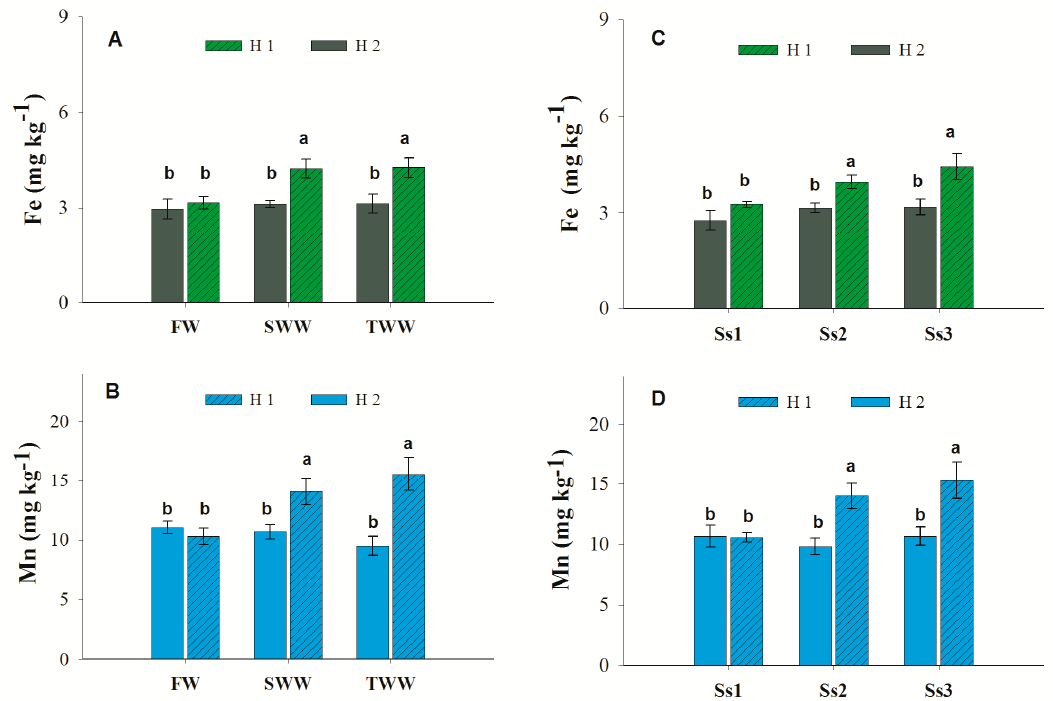
Figure 2. Diethylenetriaminepentaacetic acid (DTPA)-extractable soil content of iron ( A , C ) and manganese ( B , D ) according to the first-order interaction factors irrigation water × soil depth ( A , B ) and soil sampling date × soil depth ( C , D ). Different letters (a–b) indicate significant differences ( p ≤ 0.05; Tukey’s test). The data shown are the means ± standard errors of three replicates. S S1 , S S2 , S S3 refer to the first, second and third soil sampling dates, respectively. FW, fresh water; SWW, secondary treated wastewater; TWW, tertiary treated wastewater; H 1 , top soil profile (0–40 cm); H 2 , bottom soil profile (40–80 cm).